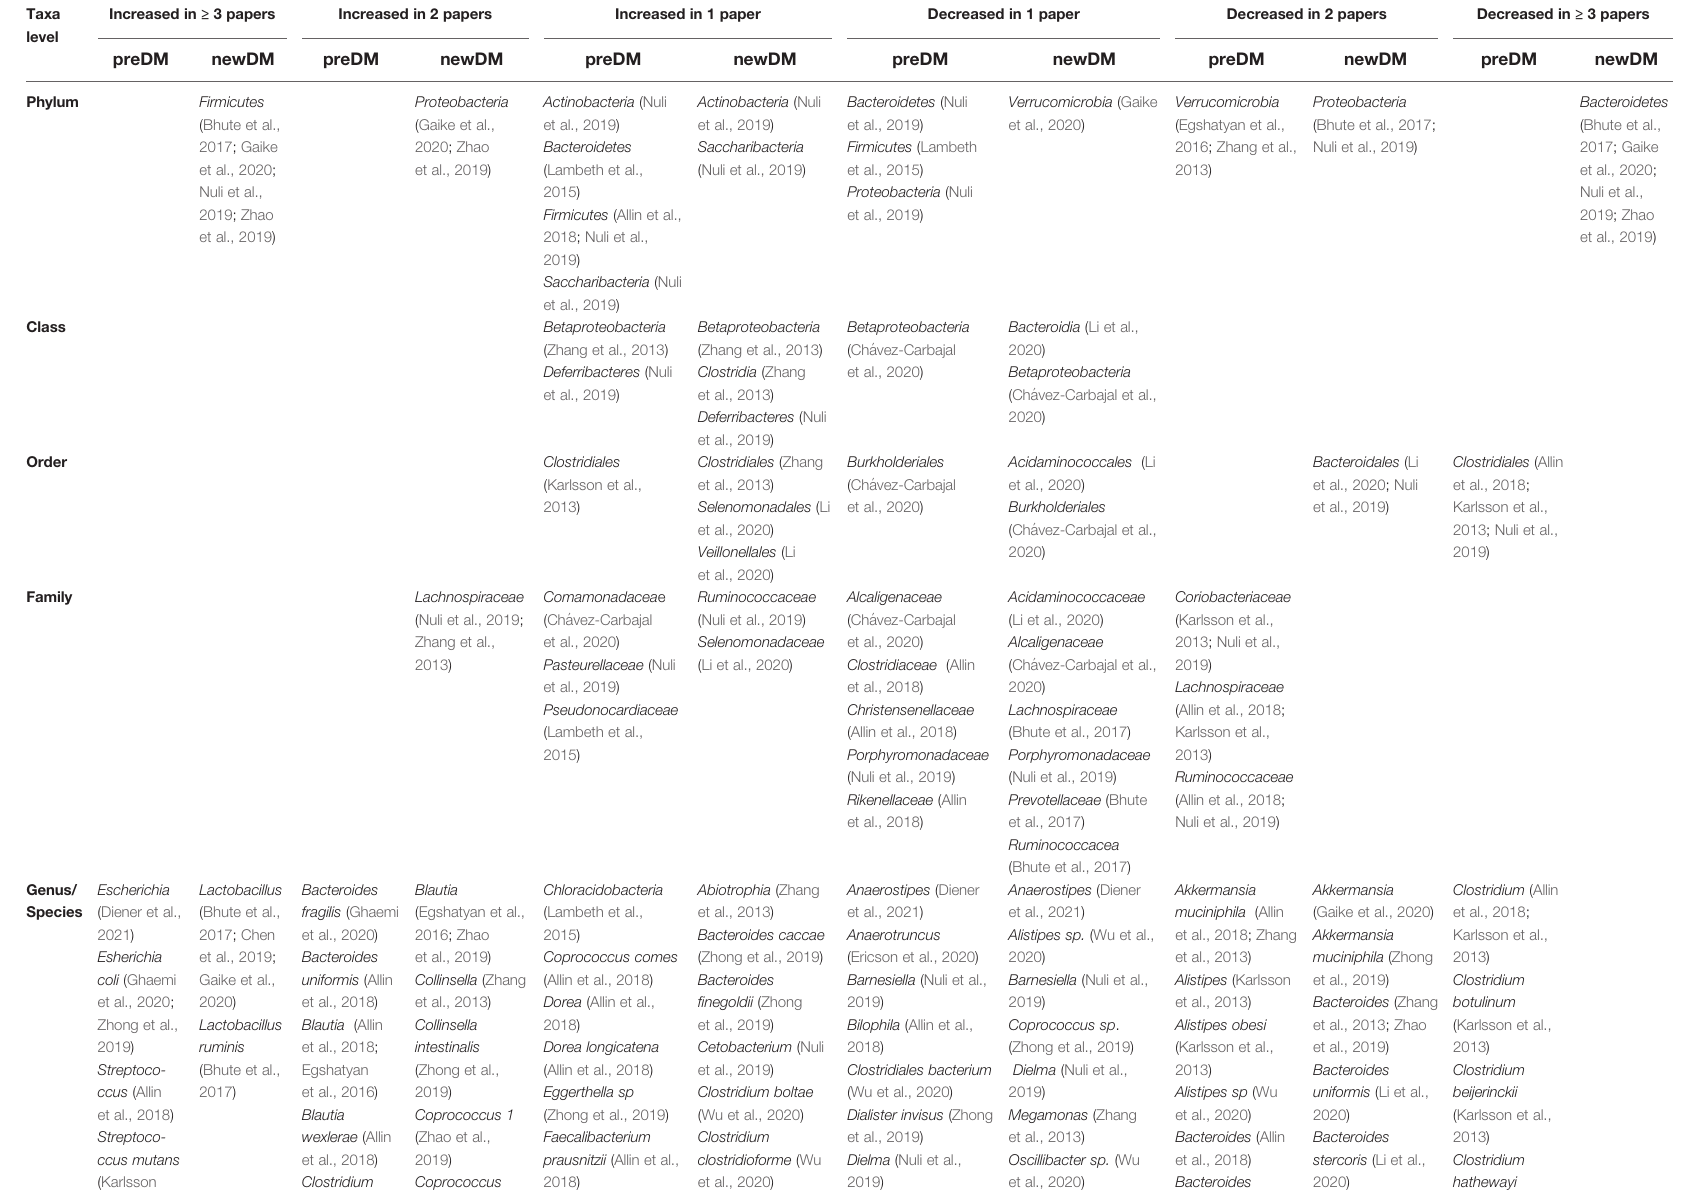
TABLE 4 | The changes (increase or decrease) noted in gut microbiota of preDM and newDM in comparison to nonDM by microbial taxa and number of reporting studies. All fi ndings are signi fi cant (p <0.050).